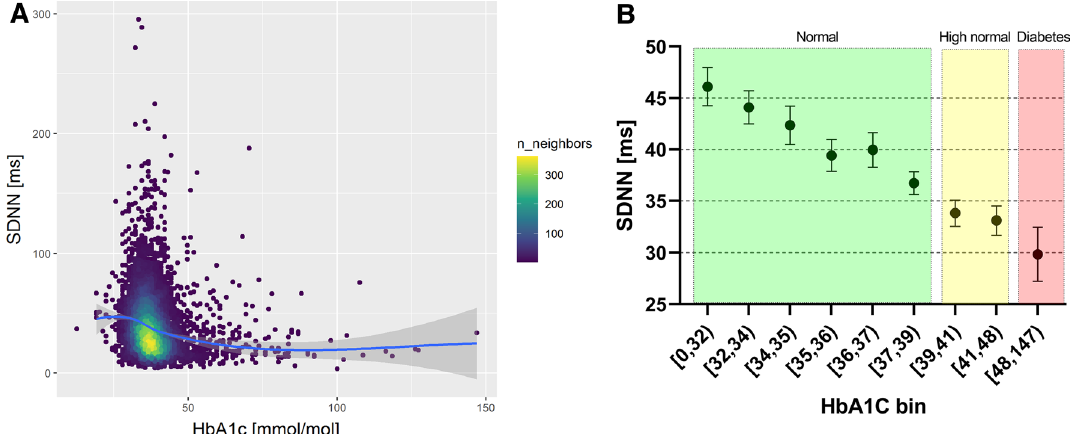
Figure 3. A Point density plot for the association between pre-CPT SDNN and HbA1c. A lighter color means that there is a higher density of observations in that area. The solid line is estimated with Locally Estimated Scatterplot Smoothing (LOESS), representing the smooth relationship between the variables (the shaded error band represents the 95% confidence interval of the LOESS). B . Mean and 95% confidence intervals of SDNN pre-CPT for participants grouped according to different HbA1c ranges. The ranges are selected in order to keep group sizes similar up to the defined level for diabetes at 48 mmol/mol and above. An HbA1c value between 39 and 48 mmol/mol is considered